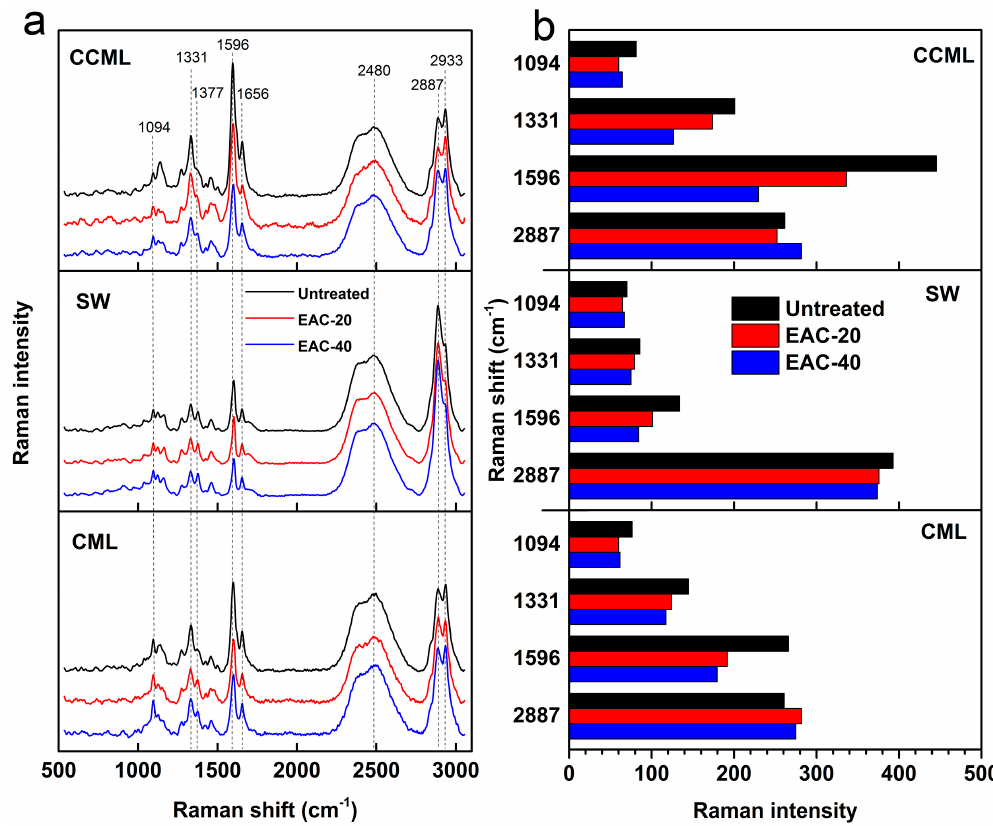
Figure 6. ( a ) Average Raman spectra for the CCML, SW, and CML regions of raw and [Emim]Ac pretreated poplar wood sections at 90 °C; ( b ) Variation of Raman intensity at four bands corresponding to lignin and carbohydrate concentration in the CCML, SW, and CML.